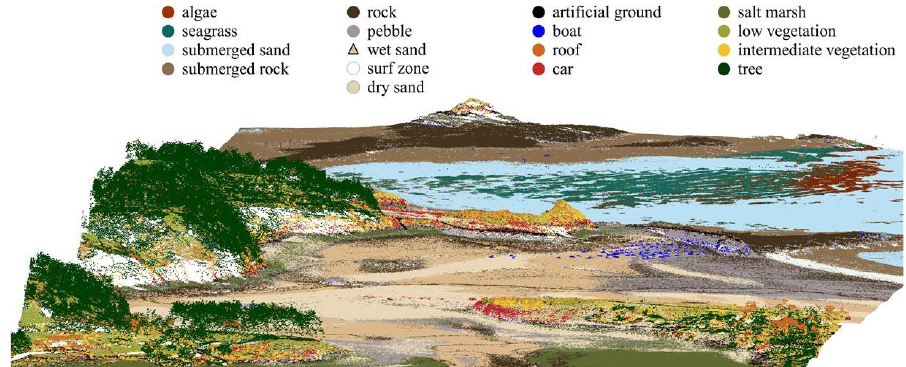
Figure 7. Resulting 3D point cloud of a coastal area and its habitats classified with full-waveform topo-bathymetric lidar